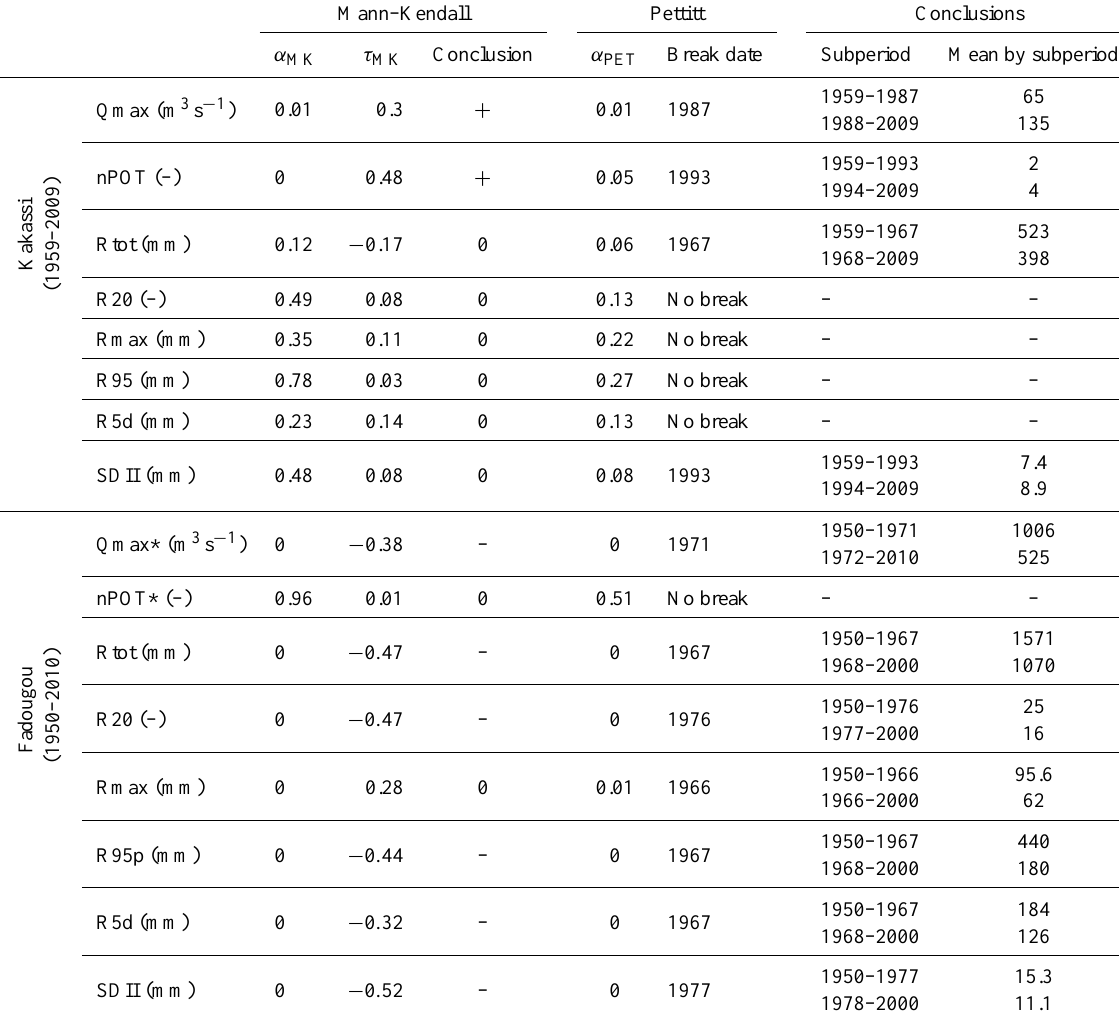
Table 4. Results of Mann–Kendall and Pettitt tests on Kakassi and Fadougou time series (flood and rainfall indices): “ + ”” for significant positive trend; “–” for significant negative trend; “0” for no significant